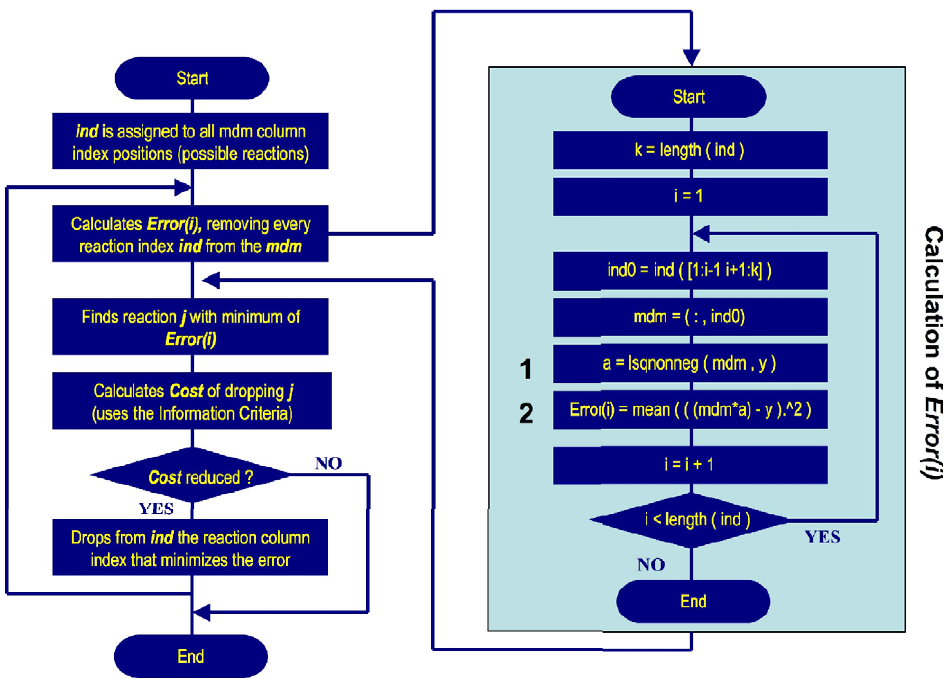
Figure 7. Model selection in MIKANA. The left flow chart shows the main steps taken in the model selection process. The right box details how we calculate the error of removing one reaction from the model design matrix mdm in MATLAB.